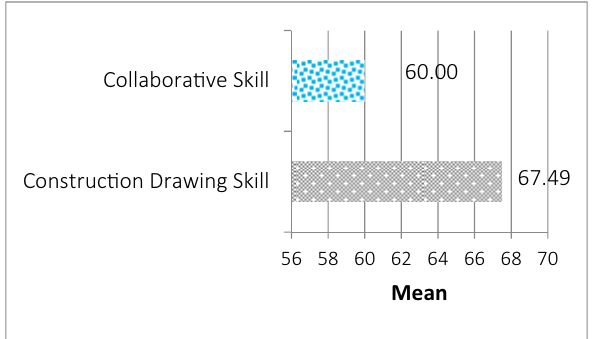
Figure 1: Students ’ construction drawing skill and collaborative skill